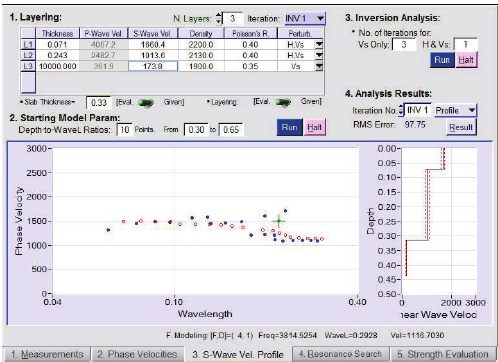
Figure 6: Gabor spectrum (contains wave groups).